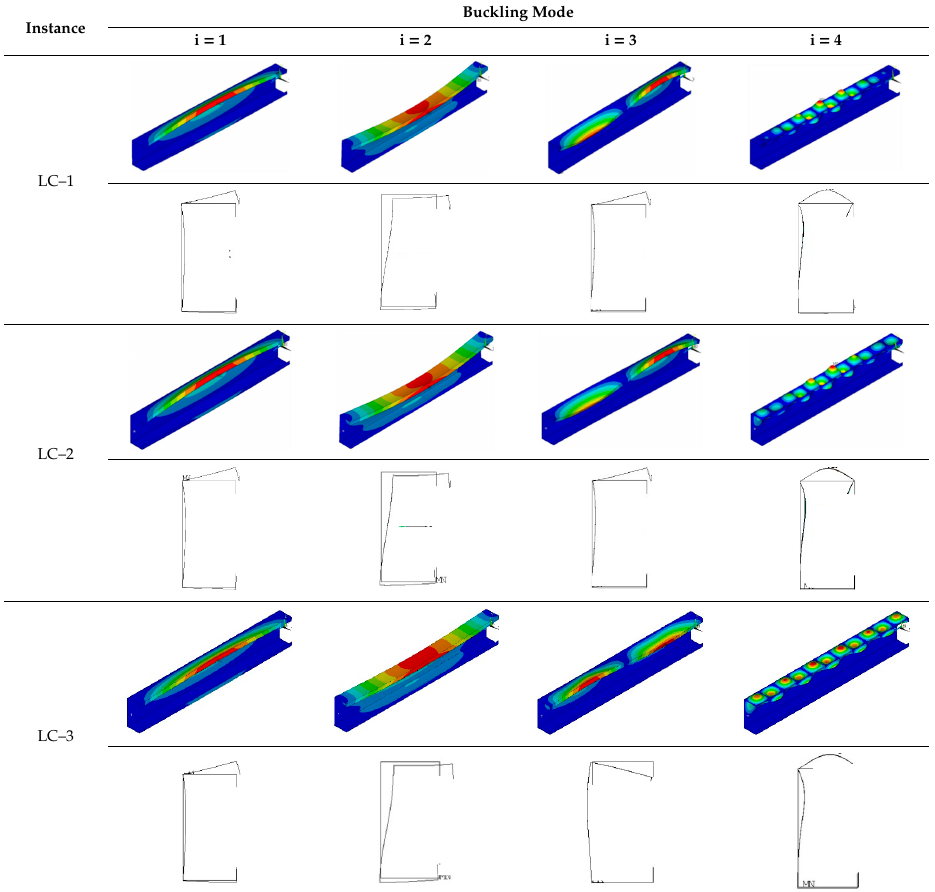
Table 6. Buckling modes of the considered FRP beams.